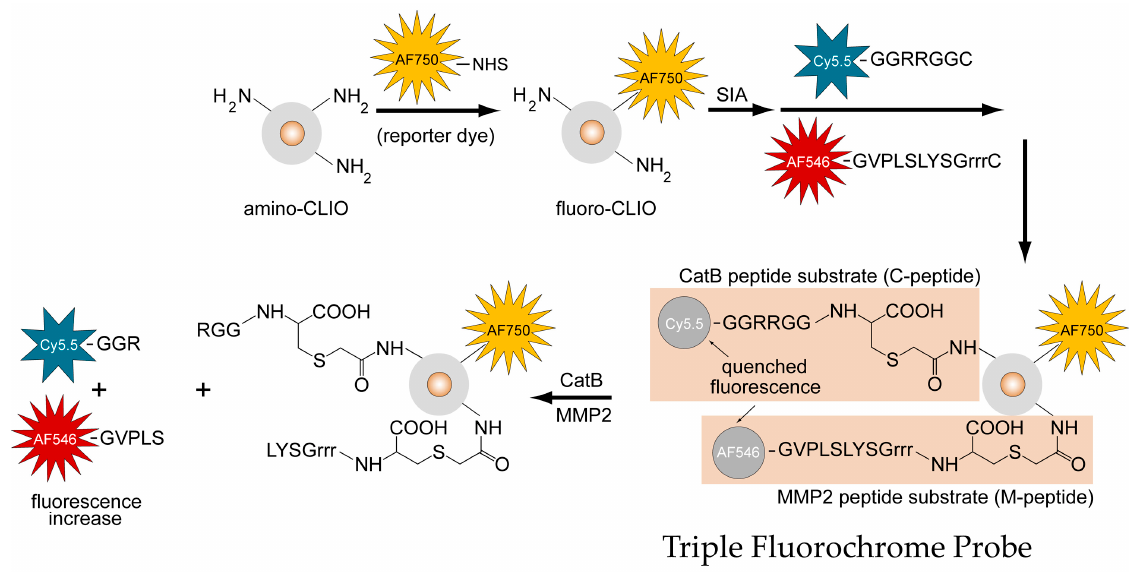
Figure 2. Design, synthesis, and activation mechanism of a triple fluorochrome probe for MMP2 and CatB activities.